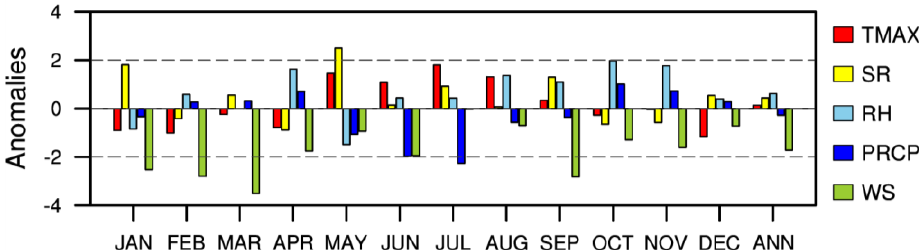
Figure 6. Normalized monthly anomalies (PRD2–PRD1) of meteorological factors, with TMAX (red), SR (yellow), RH (sky blue), PRCP (blue) and WS (green) (January, JAN; February, FEB; March, MAR; April, APR; May, MAY; Jun, JUN; July, JUL; August, AUG; September, SEP; October, OCT; November, NOV; December, DEC; Annual, ANN).